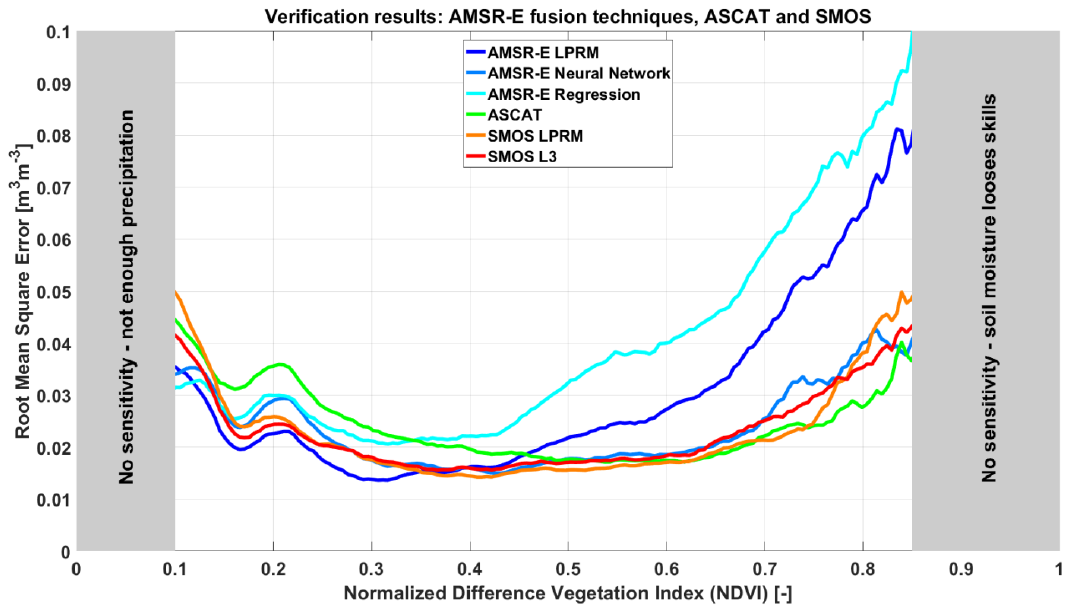
Figure 5. TCA results binned over NDVI for all six satellite soil moisture datasets.